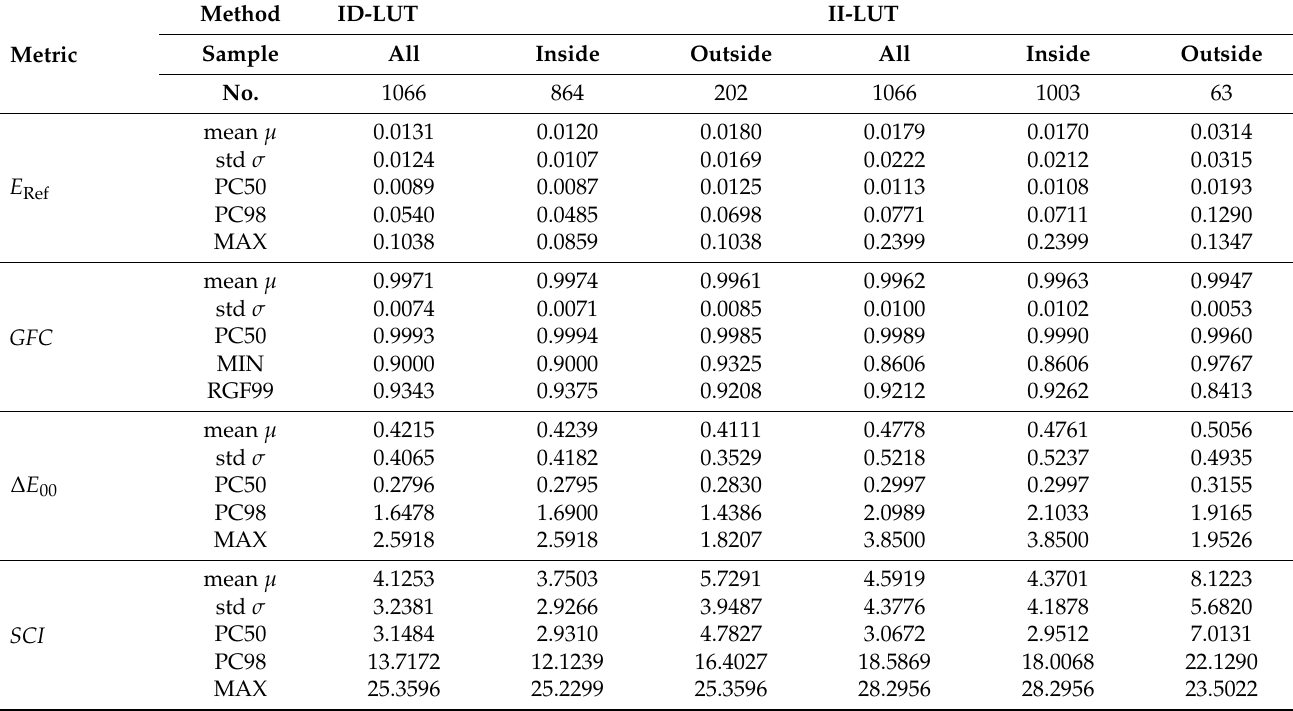
Table 5. Assessment metric statistics for the test samples using the ID-LUT and II-LUT methods, where the camera is the D5100